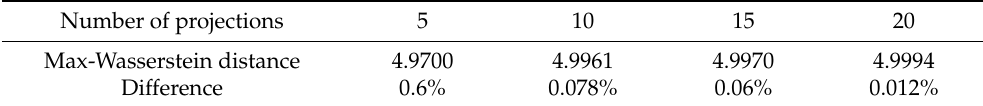
Table 2. Distance with the number of